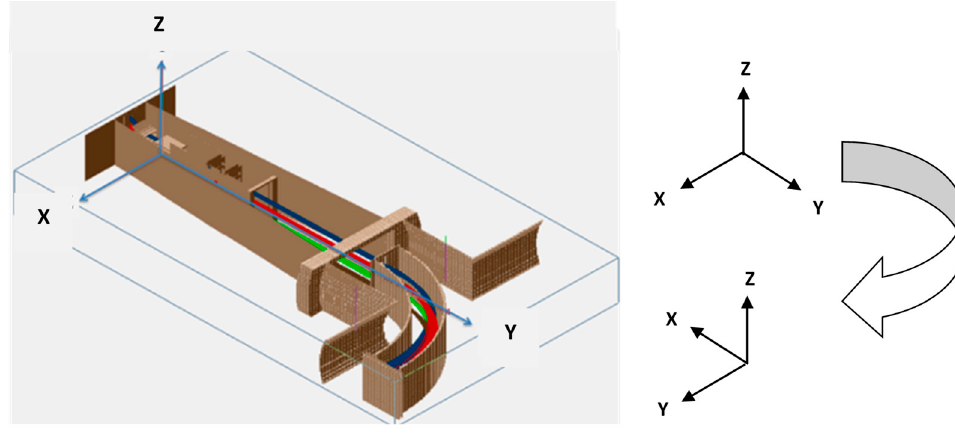
7 of 15 Figure 6. Orientation of split-line and secondary beam displacement: ( a ) beam displacement in Z direction with split-line parallel to X axis, and ( b ) beam displacement in X direction with split-line parallel to Z axis. The results of Equations (4) and (5) demonstrate the orthotropy of the δ i - h transfer characteristics for beam displacements in Z and X directions, or effective dependence on the orientation of the analyzer energy dispersion plane. As follows from Equation (4), for beam displacement in the Z direction and split-line parallel to the X axis (analyzer energy dispersion in YZ plane), the linearity of the δ iz - h characteristic is persisted for any beam profile in the XY plane, determining the effective applicability of SPD data analysis based on the assumption of secondary ion beam’s uniformity. This result applies for the HIBDs with the orientation of the analyzer energy dispersion plane coinciding with a plane of secondary beam propagation. This is typical for all traditional HIBDs operated with the injection of the angle-scanned primary beam (Figure 1b) and the mirror-type 30° Proca- Green electrostatic energy analyzer [3]. On ISTTOK, the HIBD is operated with the fixed injection angle of the primary beam (Figure 1a) and employs the 90° cylindrical energy analyzer (90° CEA) due to its multichannel operation ability along the analyzer non- dispersive direction [5]. Figure 7 shows the schematic of the 90° CEA arrangement on ISTTOK. Multichannel operation along non-dispersive Z direction is achieved by the orientation of the analyzer energy dispersion XY plane orthogonal to the YZ plane of